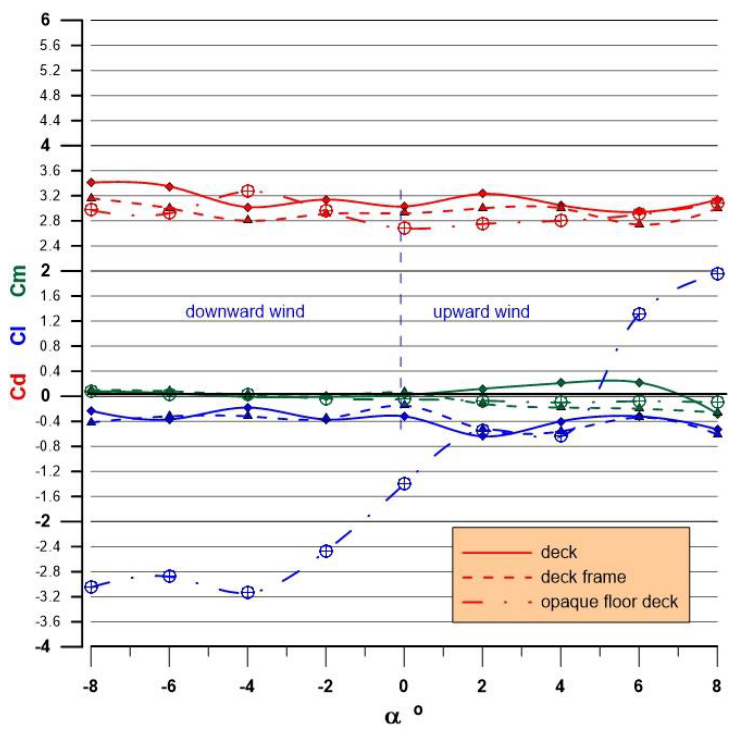
Figure 11. Evaluated aerodynamic coefficients for other deck configurations.